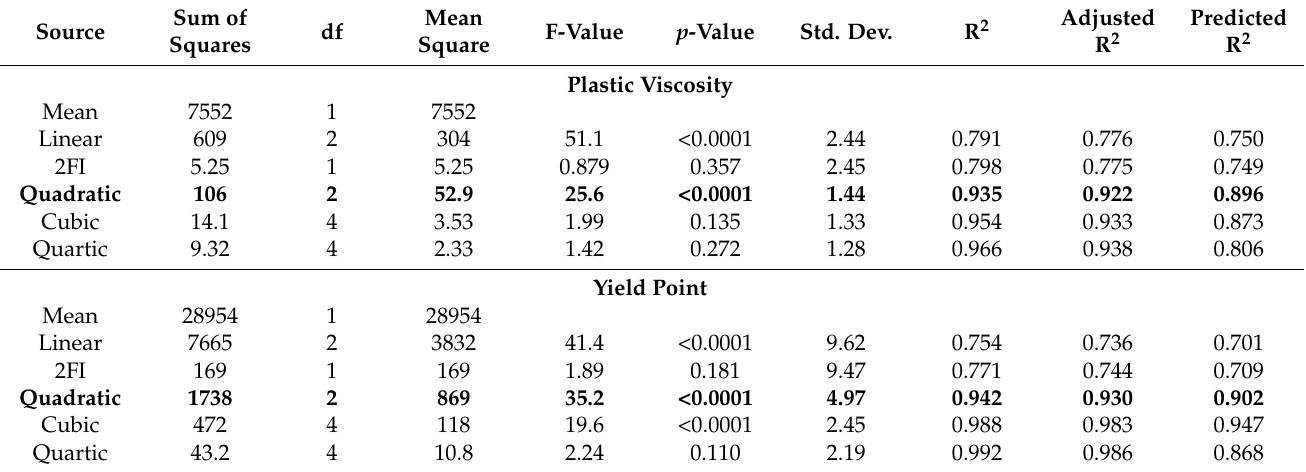
Table 3. Summary of various models and suggested models for each